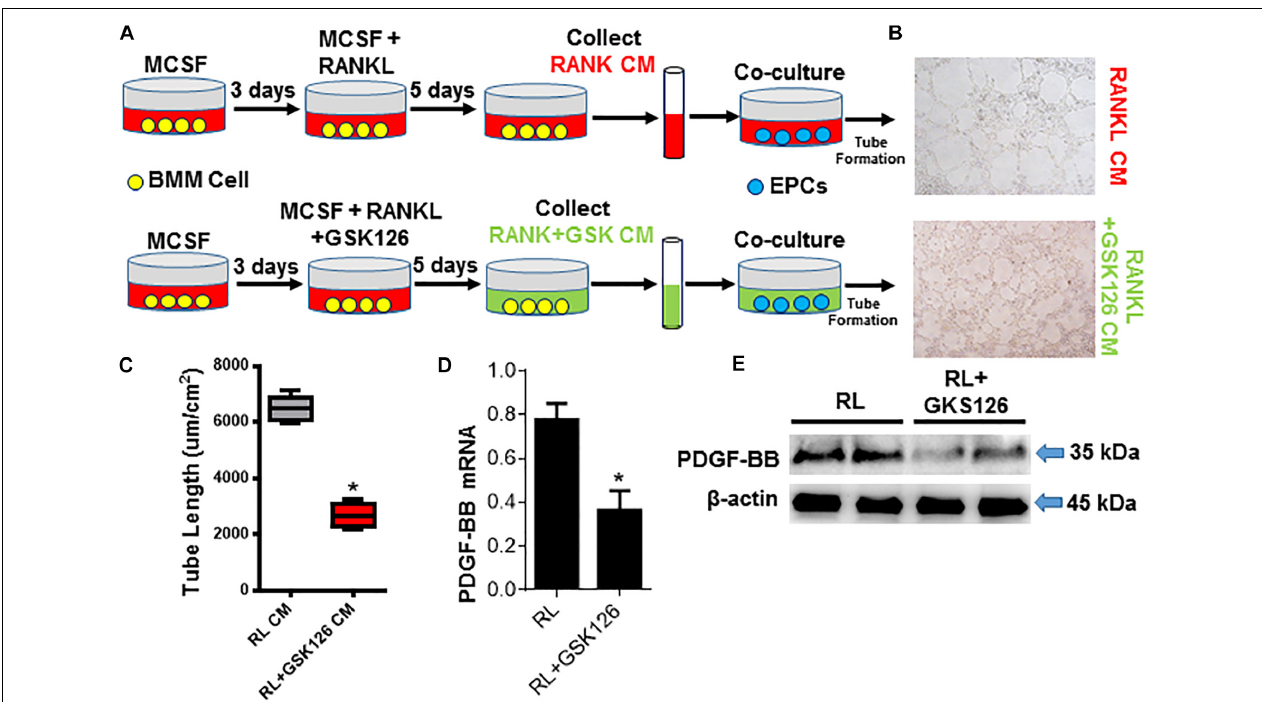
FIGURE 5 | Loss of Ezh2 suppress osteoclast precursors PDGF-BB expression and bone vasculature in ACT mice. (A) Diagram showing the procedure for the collection of condition media of OCs under denoted conditions and the co-culture with the EPCs. (B,C) Representative images (B) and tube length (C) from Matrigel endothelial tube formation assay with addition of OCLp (red) and after stimulation with RANKL/MCSF ± GSK126 (10 µ M) (green) culture media. (D,E) Quantification of Pdgfb mRNA by real-time PCR (D) and total cellular levels of PDGF-BB and β -actin by WB (E) . mRNA normalized to GAPDH. * p <